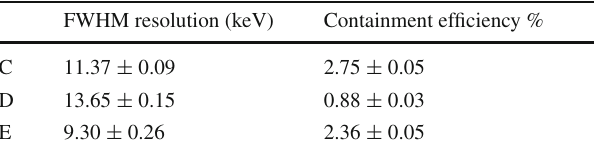
Table 2 FWHM energy resolution and containment efficiency for the three signatures of 64 Zn decay FWHM resolution (keV)